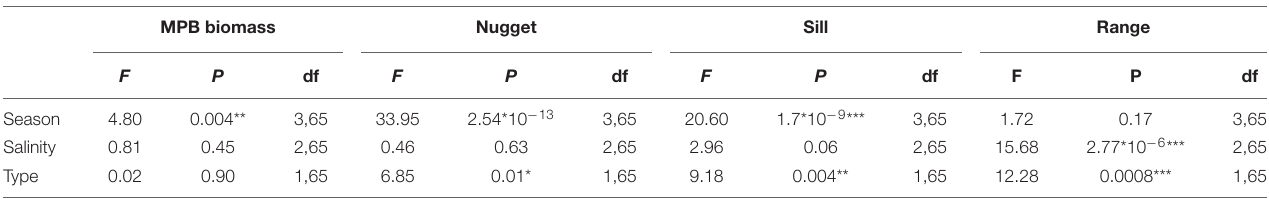
TABLE 3 | Statistics of MPB biomass and semi-variogram parameters calculated per site.